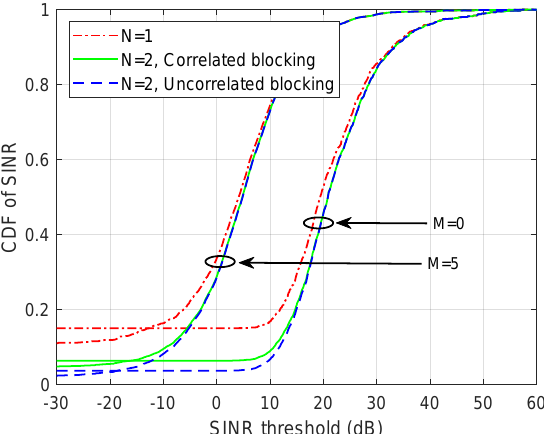
Figure 11. The distribution of Signal to Interference and Noise Ratio (SINR) over 1000 network realizations using diversity combining for different values of number of interfering transmitters. The curves are computed when N = 1,2, with and without considering blockage correlation, at fixed values of λ bs = 0.3, λ bl = 0.6, and W =